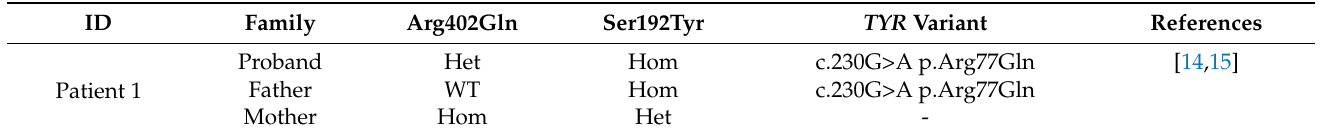
Table 2. Genetic